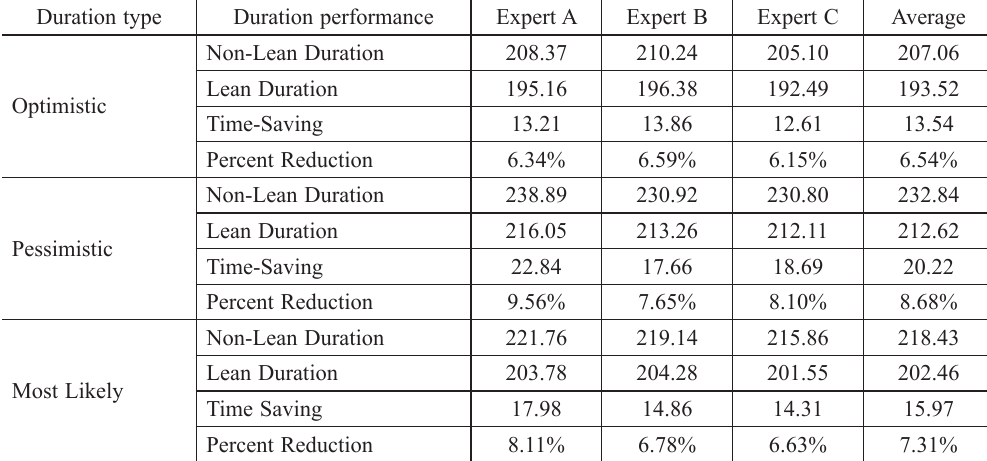
Fig. 3. Monte Carlo simulation of lean scenario Fig. 4. Monte Carlo simulation of non-lean scenario Table 7. Duration indicators of the simulation model